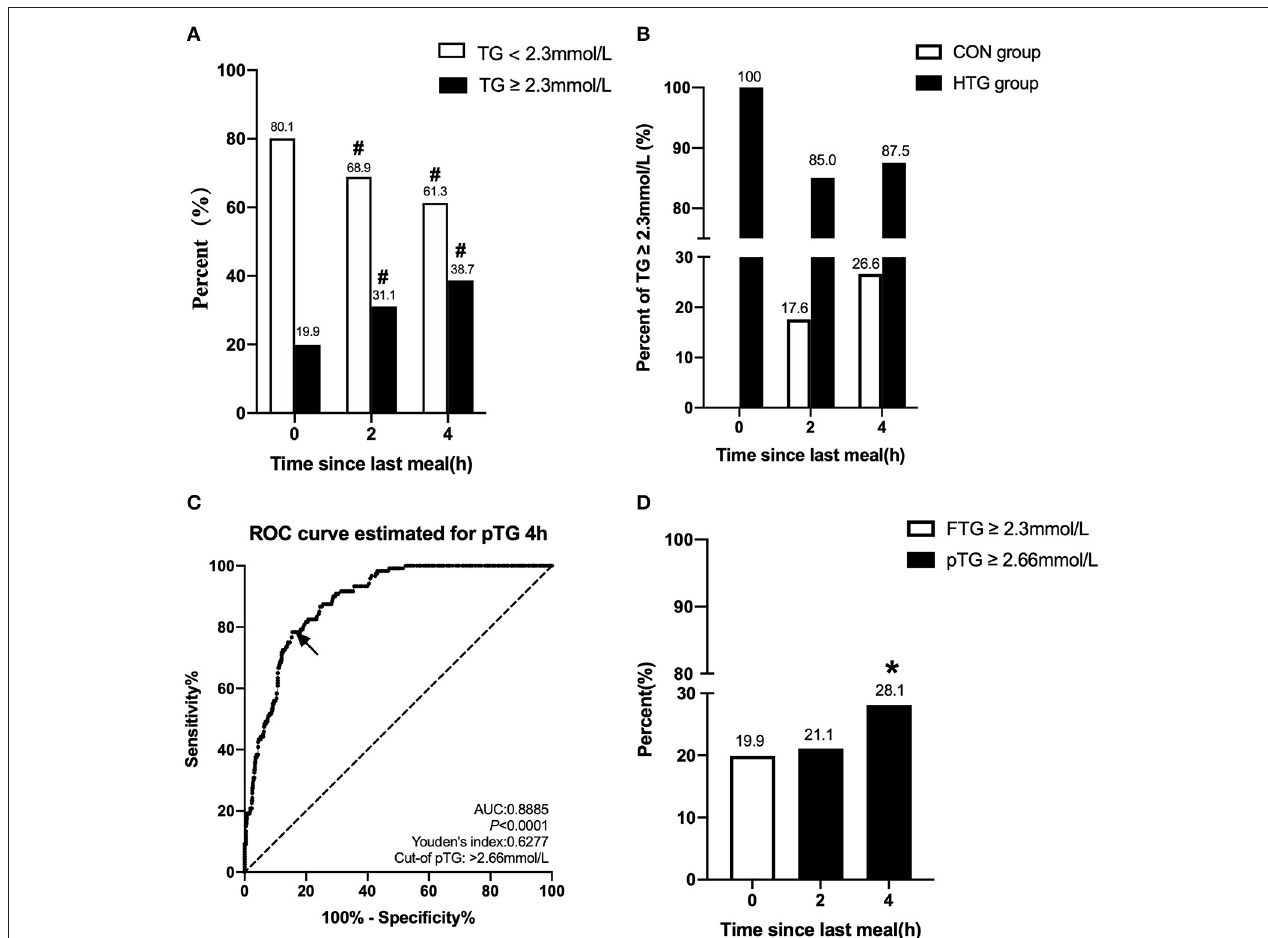
FIGURE 3 | Comparison of the percentage of HTG at different time-points and between different groups. (A) Changes in percent of TG ≥ 2.3 mmol/L and < 2.3 mmol/L in the fasting state, at 2 and 4h after a daily meal ( n = 602). (B) Difference in percent of TG ≥ 2.3 mmol/L between patients with fasting TG ≥ 2.3 mmol/L (n = 120) and < 2.3 mmol/L ( n = 482) at three different time-points. (C) Receiver operating characteristic (ROC) analysis and Youden’s index determined a cutoff point for postprandial TG level at 4h (pTG 4h) after a daily meal; the cutoff point was indicated by a solid arrow. (D) Comparisons of fasting and postprandial percentages of HTG at different time points according to the new cutoff point. # p < 0.05 when compared with the fasting level in the same group. * p < 0.05 when compared with the fasting